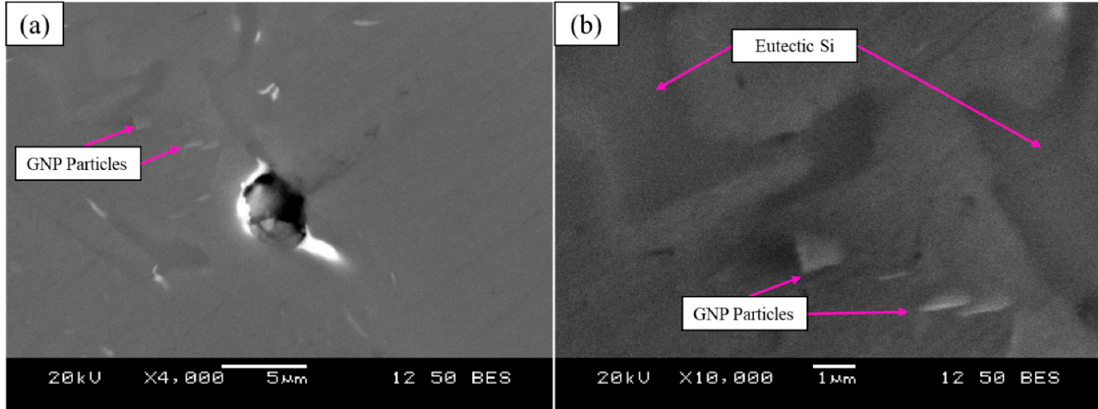
Figure 3. Backscattered SEM images of A319 + 0.05 GNP + SS + USTcomposite showing graphene nano-platelets embedded in Al matrix near eutectic Si at ( a ) 4000× and ( b ) 10,000× magnification.